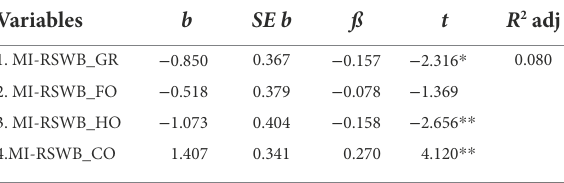
TABLE 3 Regression model: ASSIST Total Score as dependent variable predicted by the four subscales of religious/spiritual well-being.